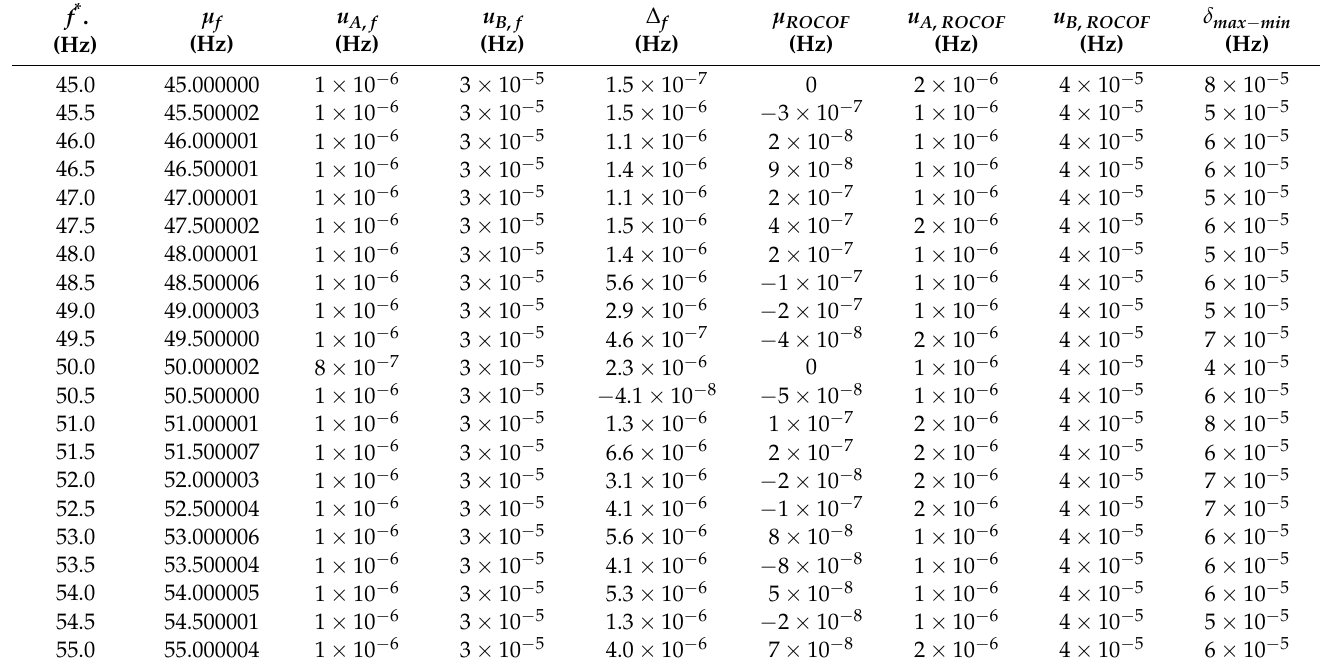
Table 8. Steady-state signal frequency characterization